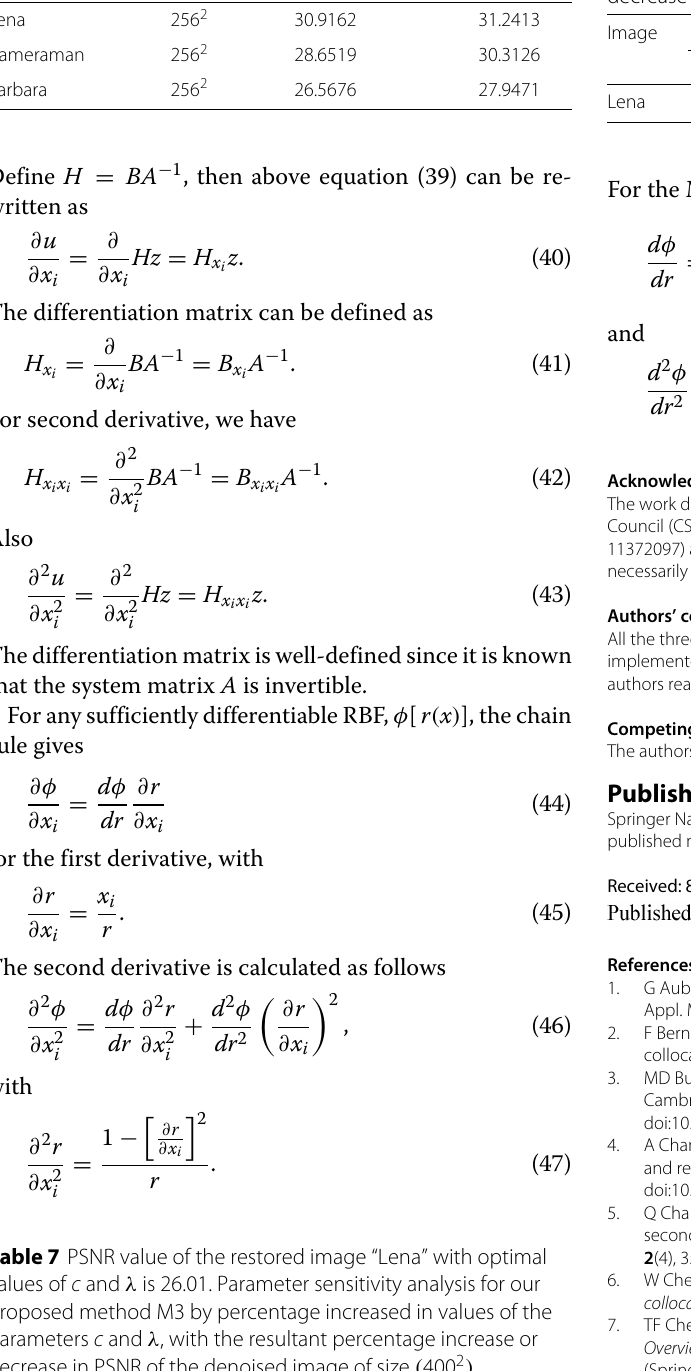
Table 8 PSNR value of the restored image “Lena” with optimal values of c and λ is 26.01. Parameter sensitivity analysis for our proposed method M3 by percentage decreased in values of the parameters c and λ , with the resultant percentage increase or decrease in PSNR of the denoised image of size ( 400 2